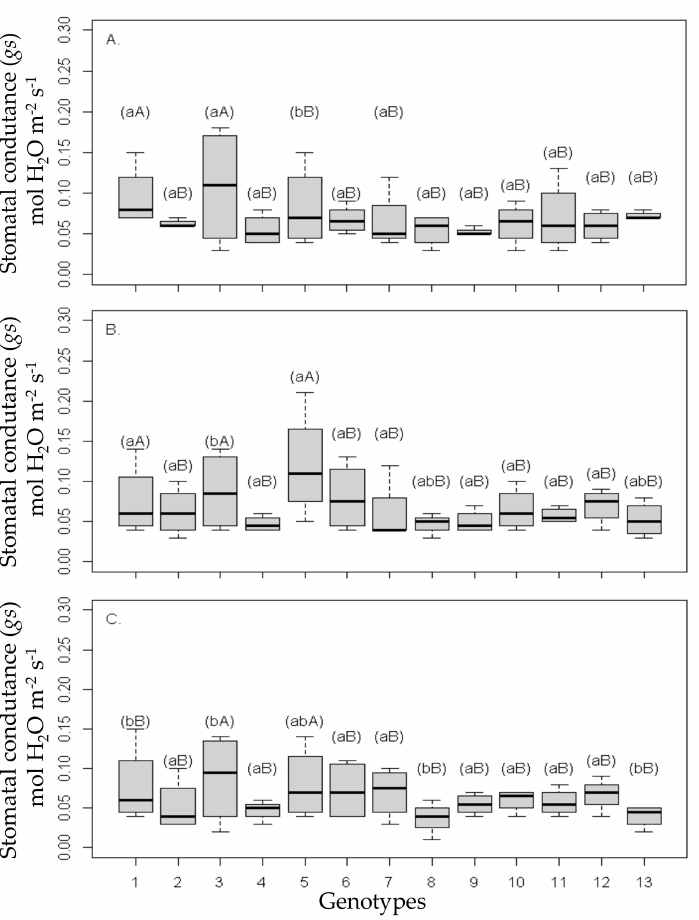
Figure 13. Boxplot relative to the average stomatal conductance ( gs ) of 13 citrus rootstocks in combination with ‘Tahiti’ acid lime ( Citrus × latifolia (Yu. Tanaka) Tanaka) under irrigation with Table 1. Boxplots with the same lowercase letter do not differ statistically, according to the Tukey test between salinity levels ( p ≤ 0.05), and those with the same uppercase letter belong to the same genotype group, according to the Scott–Knott test ( p ≤